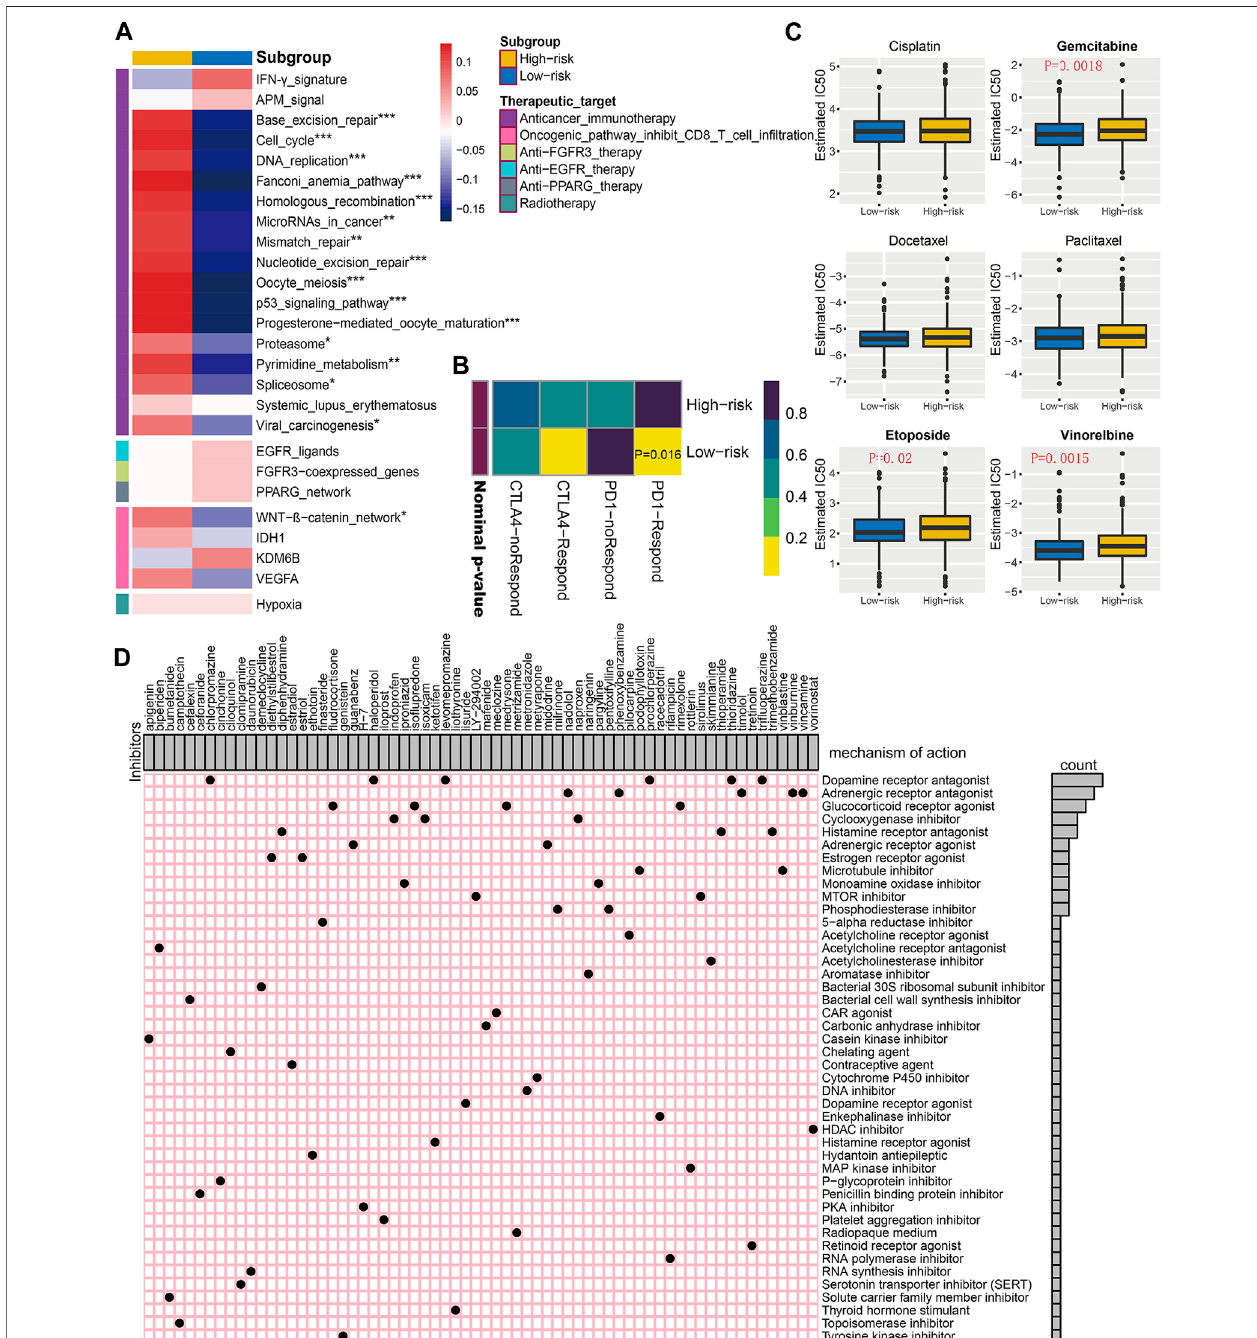
FIGURE 9 | Correlation of established risk score with therapeutic response to several therapies in BC patients. (A) Differences in enrichment scores (average z-scores) ofseveral therapeutic signatures for low- and high-risk patients. (B) Immunotherapeutic response prediction for anti-PD-1 and anti-CTLA-4 treatments inlow- and high-risk patients. (C) Differential chemotherapeutic responses for distinct risk subgroups. Boxplots showing the estimated IC50 of risk subgroups for particular chemotherapeutic drugs, including cisplatin, gemcitabine, docetaxel, paclitaxel, etoposide, and vinorelbine. (D) Potential molecular inhibitors derived from Connectivity Map analysis (CMap). Based on the differential expression genes between distinct risk subgroups, we utilized the heatmap to depict each compound (perturbagen) from CMap database that shares similar mechanism of action (MoA). Sorted by descending number of inhibitors with shared MoA.